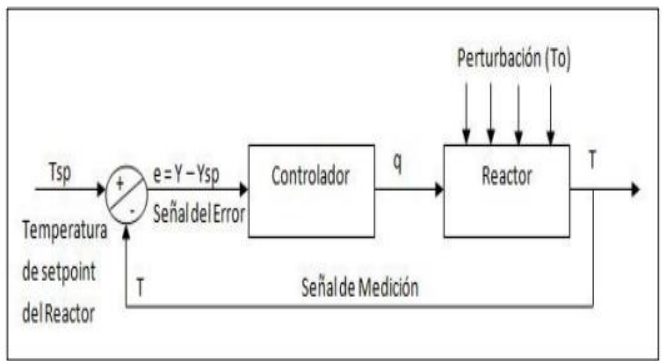
Figura 4: Lazo de control de temperatura T(t) de un Reactor químico tipo tanque continuamente agitado (CSTR).